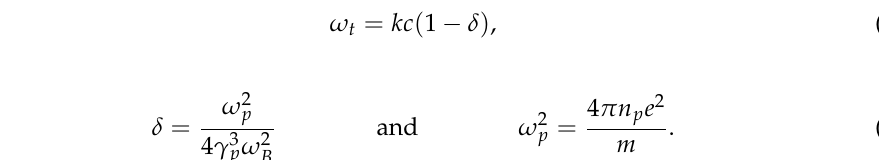
of a high-frequency-emission generation process. It is worth noting that the cyclotron waves are vacuum-like electromagnetic waves, which can leave the pulsar magnetosphere freely, reaching an observer as pulsar-pulsed emission. As a very precise feature of this mechanism, the low- and high-frequency waves are generated almost simultaneously in the same location of the pulsar magnetosphere, ensuring the phase-coincidence of emission impulses in these